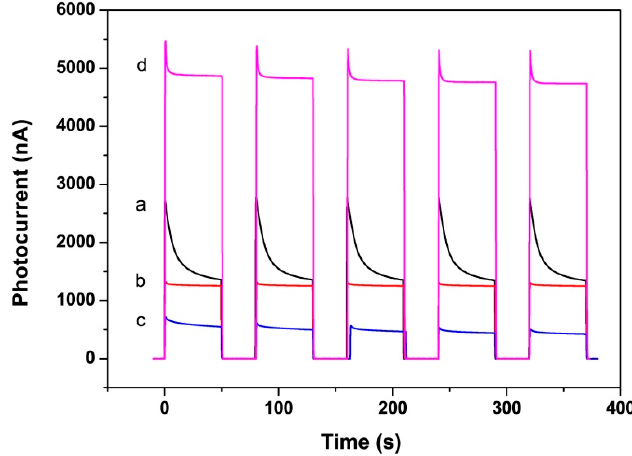
Figure 4. Photocurrent responses of di ff erent electrodes: ( a ) TiO 2 NTs / Ti, ( b ) Pt / TiO 2 NTs / Ti, ( c ) IrO 2 / TiO 2 NTs / Ti, ( d ) Pt-IrO 2 / TiO 2 NTs / Ti electrodes in 0.1M PBS solution under 365 nm LED irradiation.